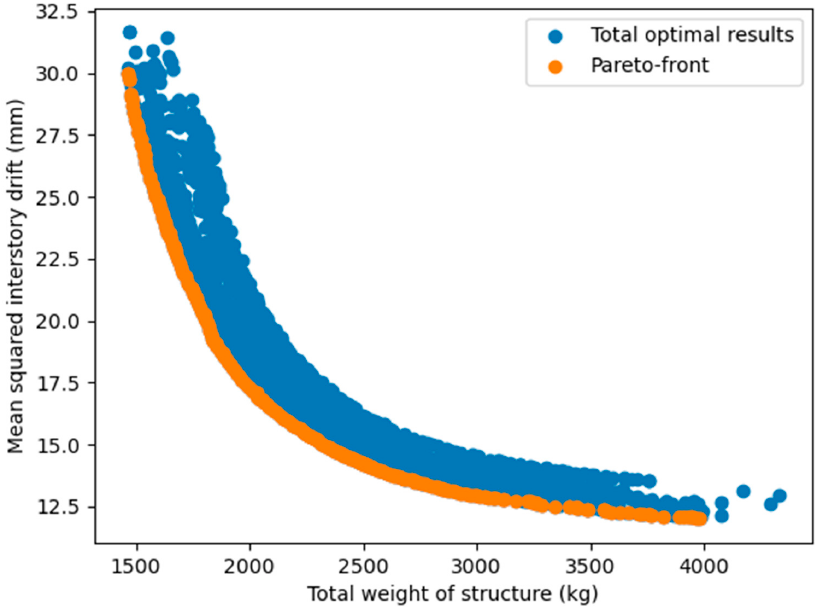
Figure 14. The approximate Pareto-front of the 47-bar power line.